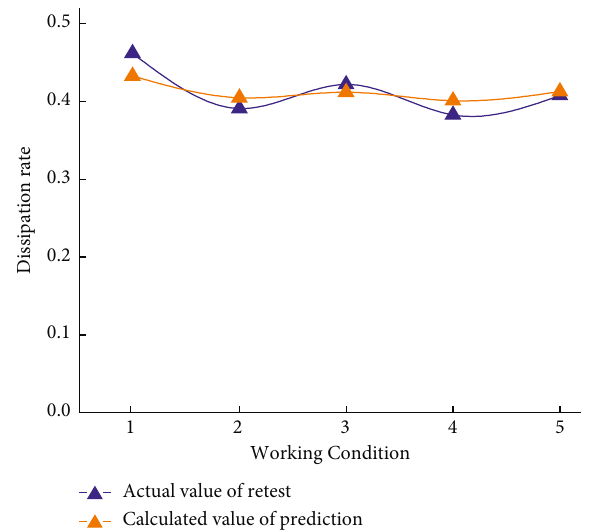
Figure 6: Comparison of the calculated values of the prediction model verification groups and the actual values of the